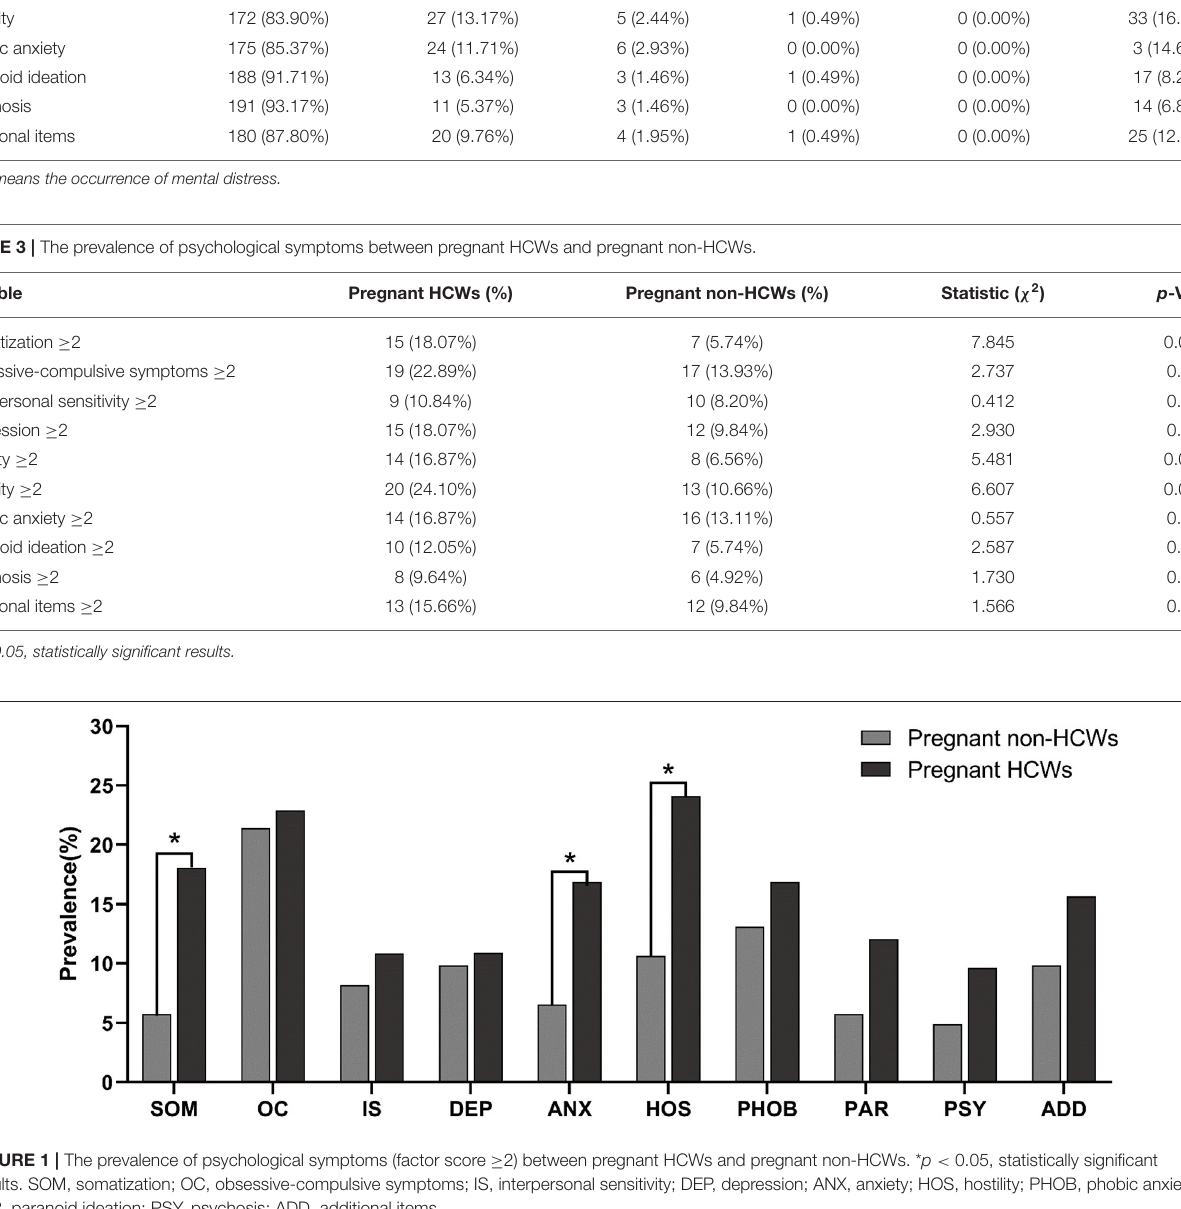
pregnant non-HCWs; and group 3: pregnant